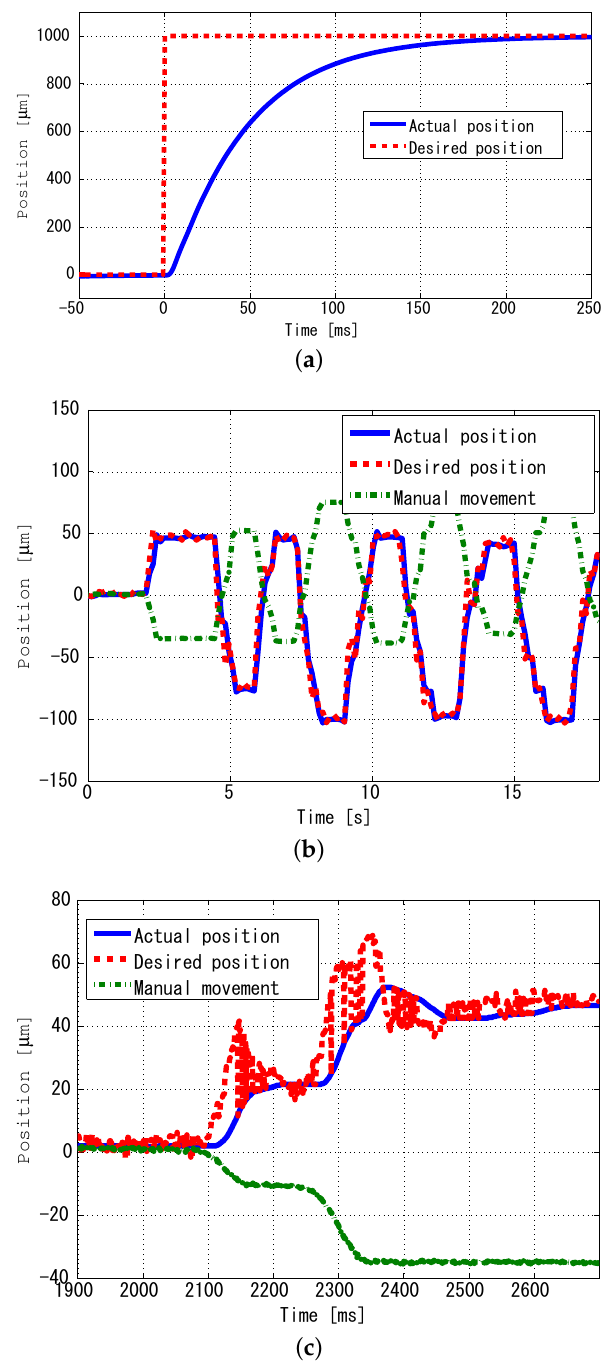
Figure 11. Focus tracking results. ( a ) Step response of the automated stage. In this figure, the actual position shown in the blue solid line shows the current stage position. The desired position shown in the red dashed line is the command value for moving the stage position to the target position. In this figure, the target position is assumed to be 1000 µ m; ( b ) Tracking results. Actual position indicates the current position of automated stage. Desired position indicates the command value for automated stage. Manual movement is the displacement of the manual base under the automated stage; ( c ) Enlarged view of ( b ) at 1700 µ s to 3000 µ